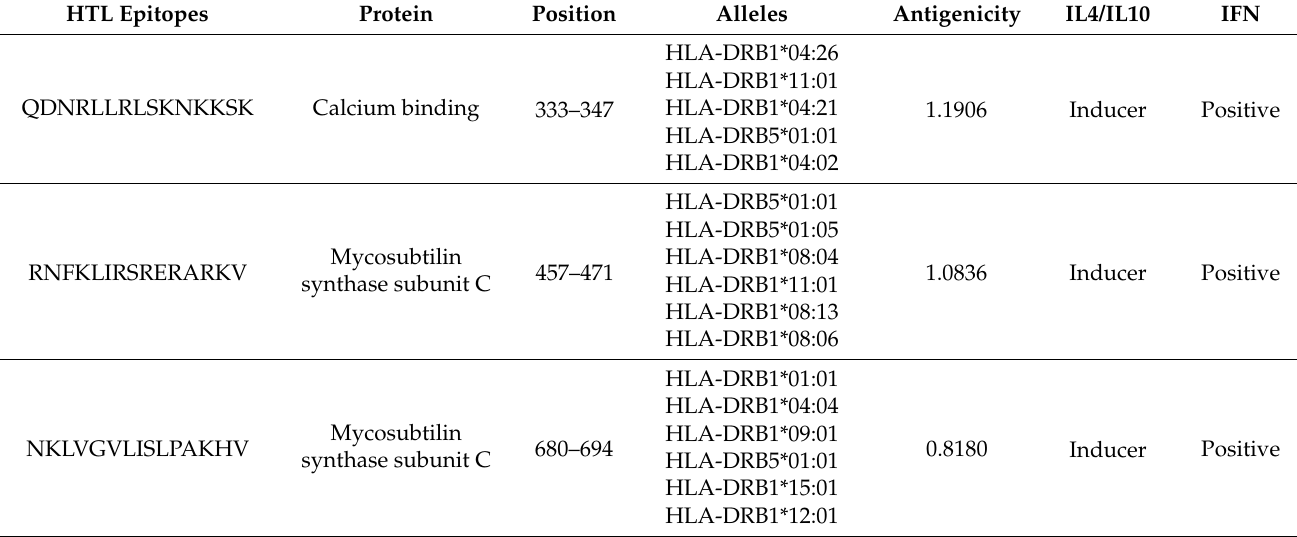
Table 3. Screened HTL epitopes for MEV